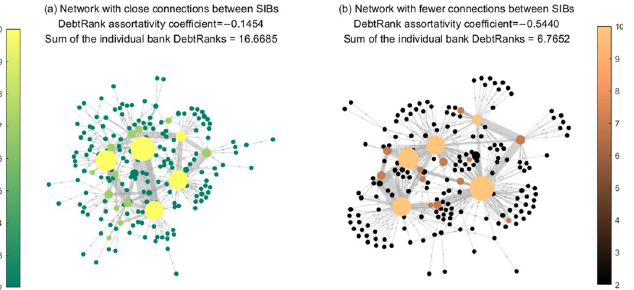
Fig 1. The systemic vulnerability in networks with different connection tendencies of SIBs. The interbank network in Fig 1(a) is estimated by the minimum density method based on the data of 188 banks’ interbank assets and interbank liability in 2019. In Fig 1(b) , the SIBs’ cluster patterns are restructured without changing the economic conditions of Fig 1(a) , such as total interbank assets/liabilities and capital buffer. The nodes’ size is positively related to banks’ equity in the figure. The amount of interbank lending/borrowing determines the thickness of the gray lines linking the nodes. Nodes with light to dark colors correspond to large-scale state-owned, joint-stock, and other banks, respectively. The DebtRank assortativity coefficient indicates banks’ tendency to connect with others with a similar DebtRank level.